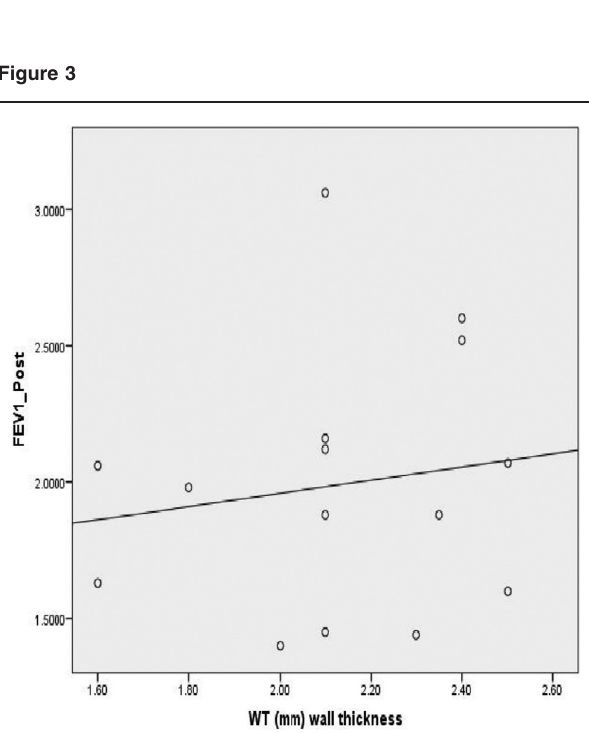
Correlation of a forced expiratory volume in 1s after bronchodilator therapy with airway wall thickness assessed in HRCT among patients with asthma – chronic obstructive pulmonary disease